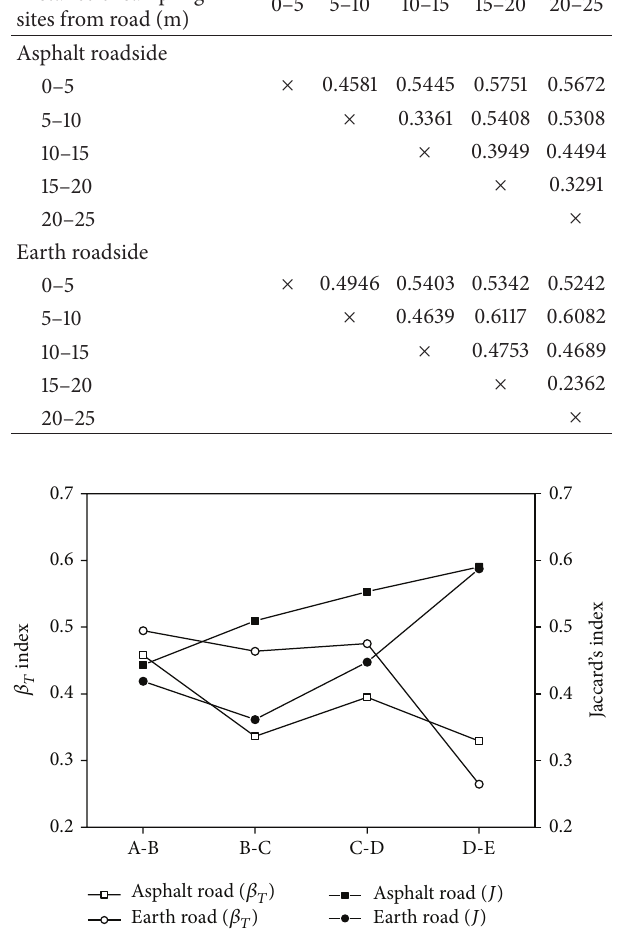
Figure 5: Characteristic of 𝛽 𝑇 index and Jaccard’s coefficient in plots of the asphalt roadsides and earth roadsides. A: plant communities in plots of 0–5 m to road verge; B: plant communities in plots of 5– 10m to road verge; C: plant communities in plots of 10–15m to road verge; D: plant communities in plots of 15–20 m to road verge; E: plant communities in plots of 20–25 m to road